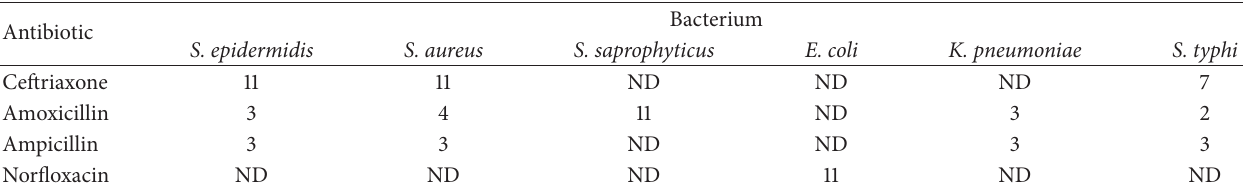
Table 7: Minimal Inhibitory Concentrations of resistant antibiotics.